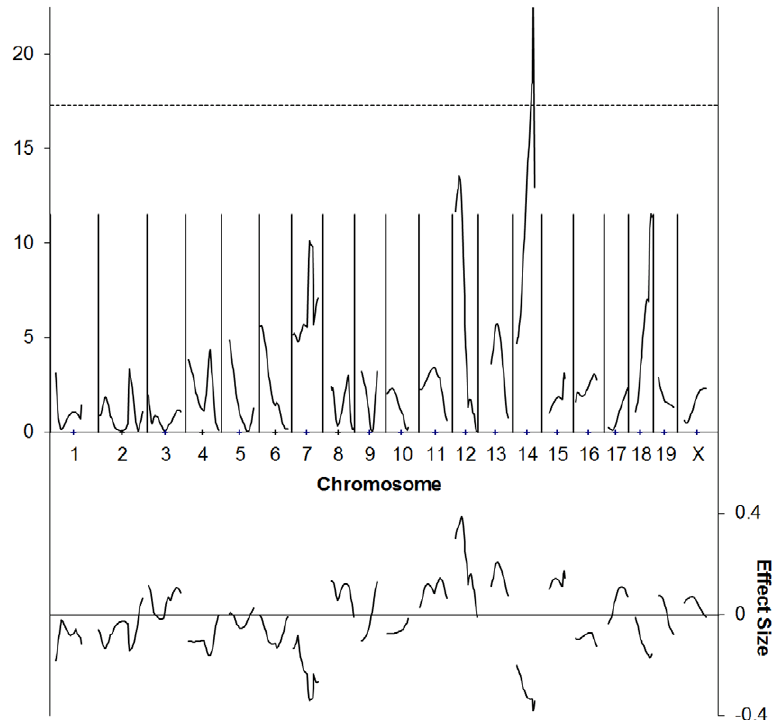
Figure 2. C57BL/6J 6 129P3/J F2 cross simple interval mapping. Whole genome simple interval map. Top: likelihood ratio statistic or likelihood of a region being linked to bFGF-induced corneal neovascularization. Dashed line indicates P=0.05 as determined by bootstrapping. Bottom: predicted additive effect of a region on bFGF-induced corneal neovascularization.